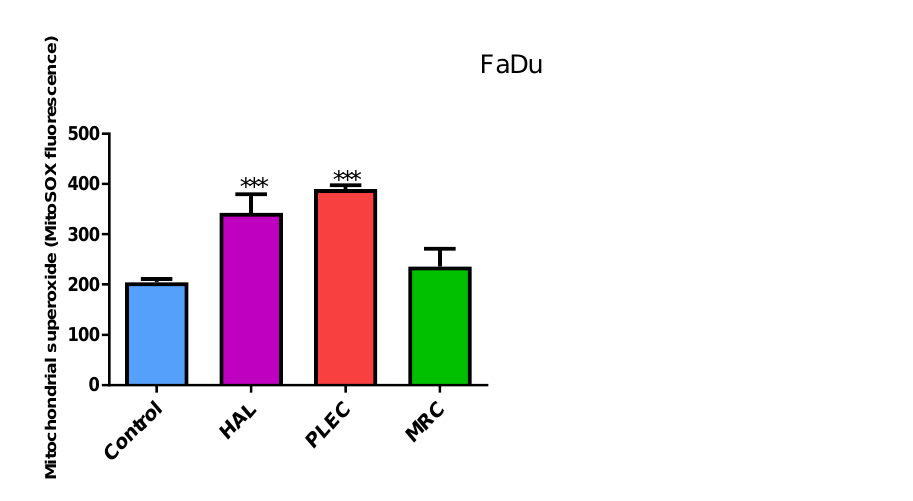
Figure 3. Generation of mitochondrial superoxide in MCF7 and FaDu cells as detected with MitoSOX. The cells were exposed to HAL, PLEC and MRC and, after 24 h of incubation, MitoSOX Red fluorescence was measured using a microplate reader. Data are means ± SD (n = 3). *** ( p < 0.001) as compared with control (untreated) cells.